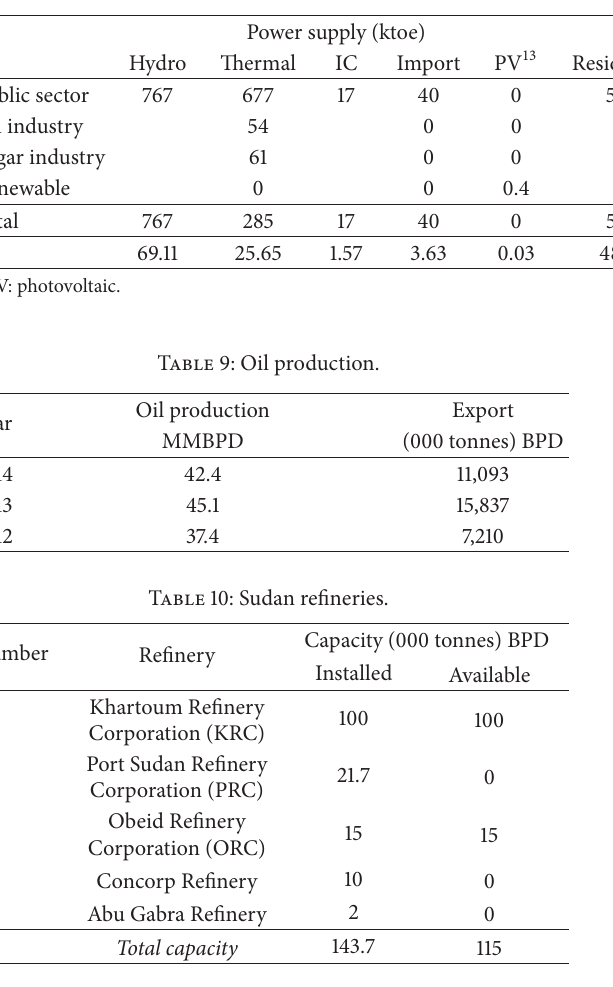
Table 8: Electric power supply and consumption in base year 2014.